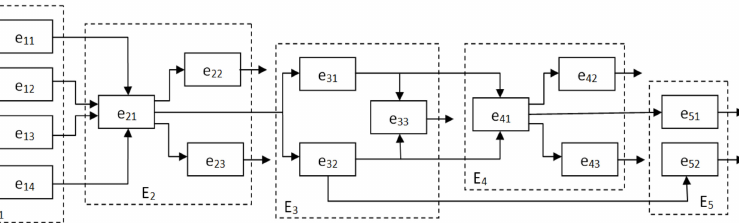
Figure 6. Diagram of functional and diagnostic structure of low-power solar plant